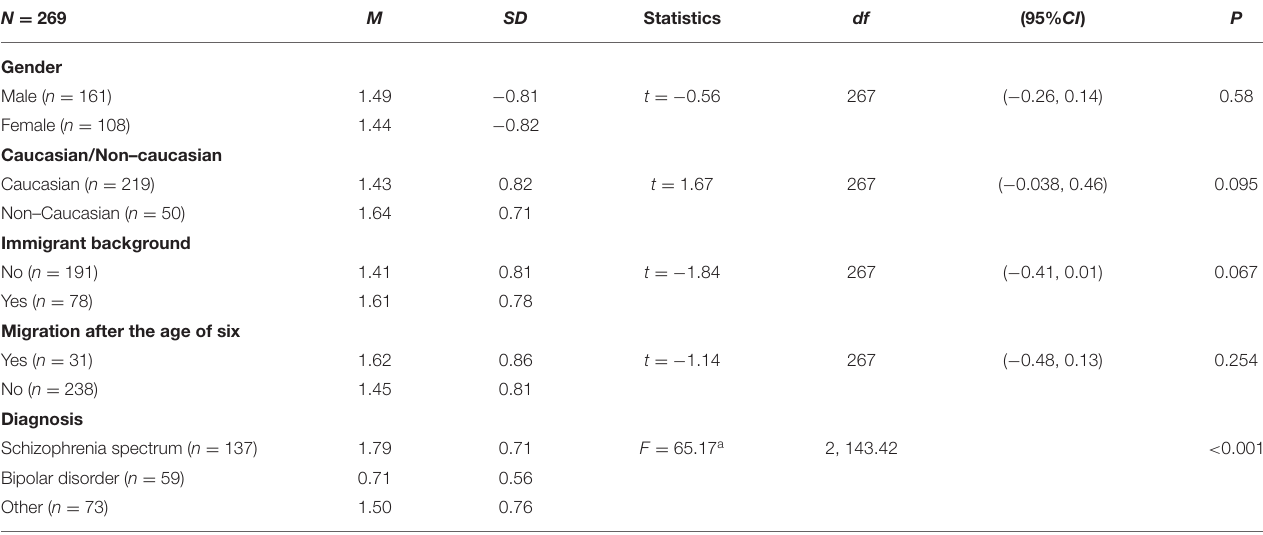
TABLE 2 | Comparison of duration of untreated psychosis (DUP) across sociodemographic and clinical characteristics. N = 269 M SD